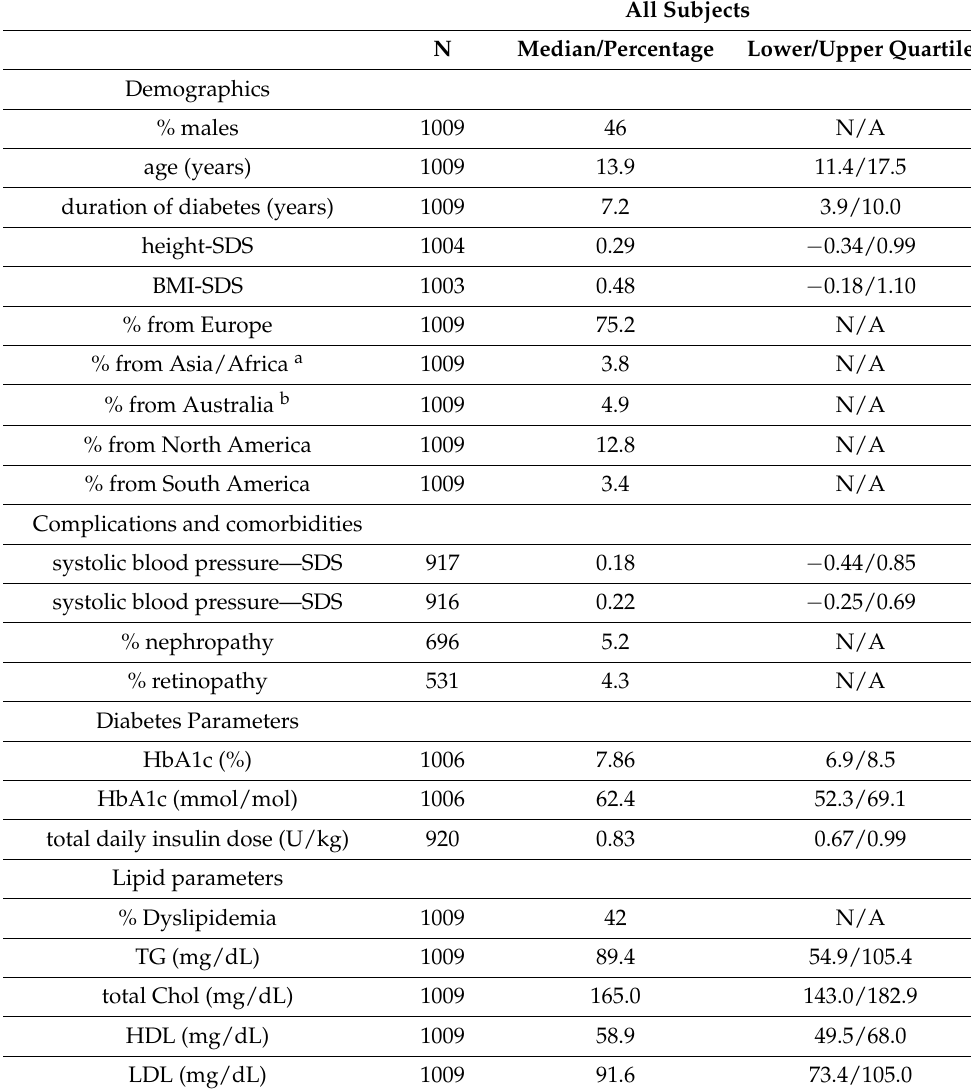
Table 1. Demographics of study population, stratified by insulin